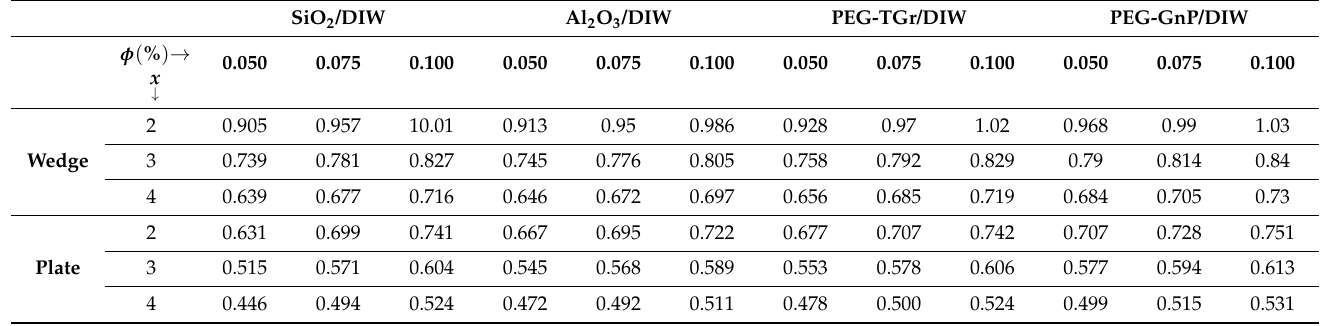
Table 14. Coefficient of Skin friction 10 − 3 × C f of schematic nanofluids over the wedge and plate at different nanoparticle volume fractions and distinct